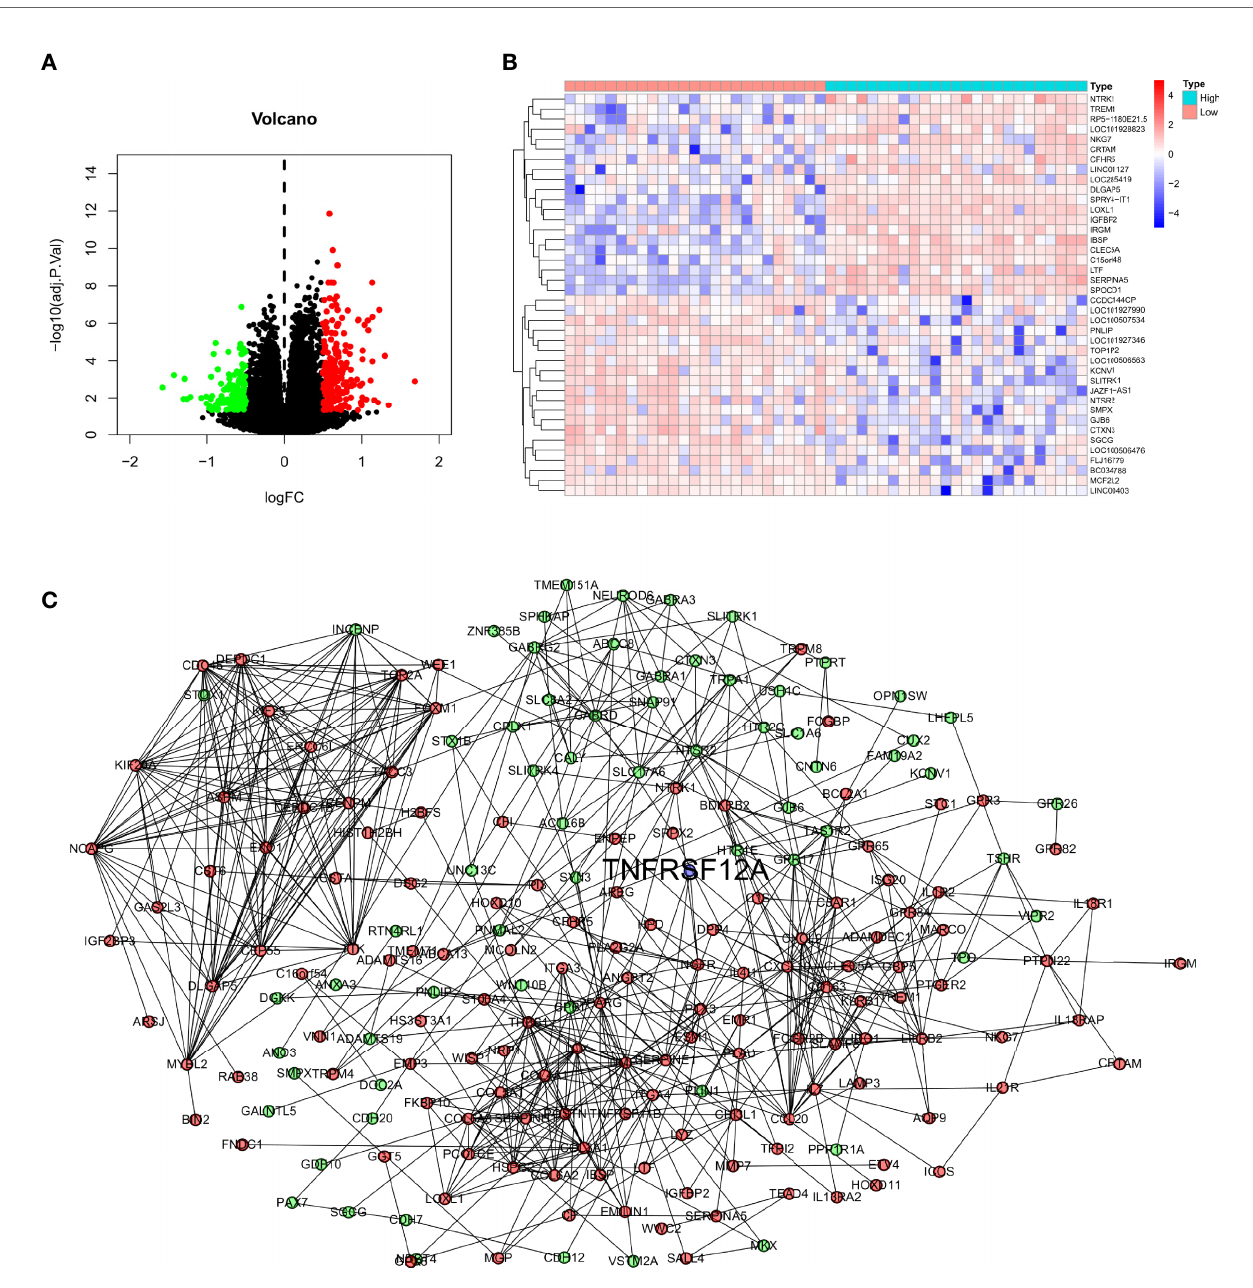
FIGURE 8 | (A) Volcano map of DEGs in GSE43378. (B) Correlation heat map of the 20 up- and down-regulated most signi fi cant DEGs in GSE43378. (C) PPI network for DEGs of GSE43378 in String database, red dots indicate up-regulated genes, green dots indicate down-regulated genes, and blue dots indicate target